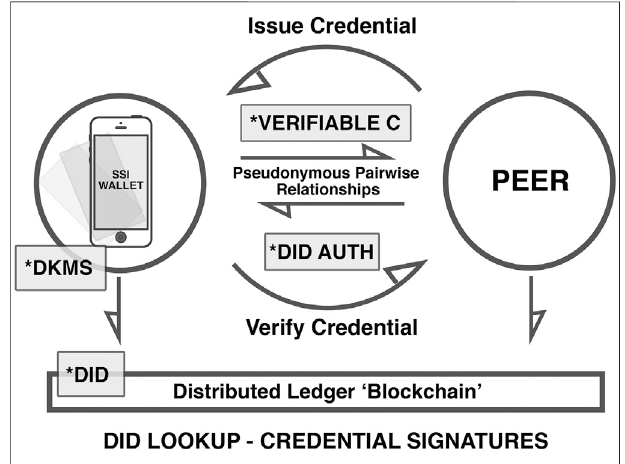
FIGURE 2 | The component parts of an SSI